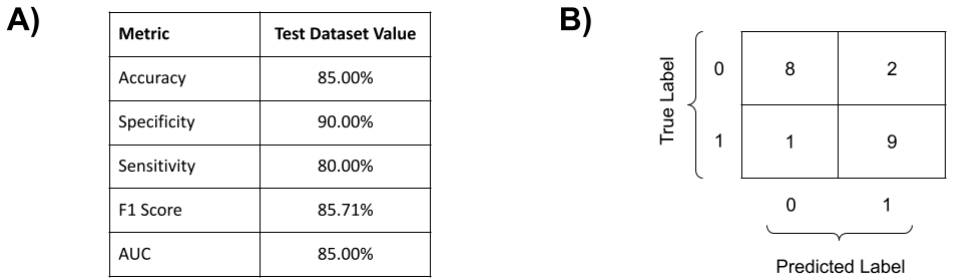
Figure 2. General performance of our human genome polymorphisms/machine learning COVID-19 prognosis classifier (SVM evaluation with Linear Kernel over 20 test samples: 10 mild cases and 10 severe cases). ( A ) Evaluation metrics for our complex COVID-19 classifier. ( B ) Confusion matrix: class 0 stands for mild cases, whereas class 1 stands for severe cases of COVID-19.